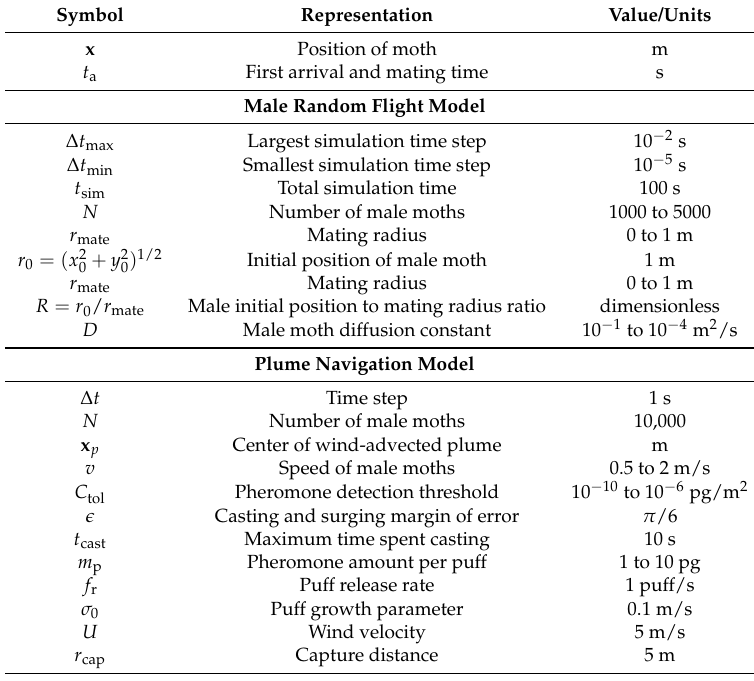
Table 1. Summary of variables